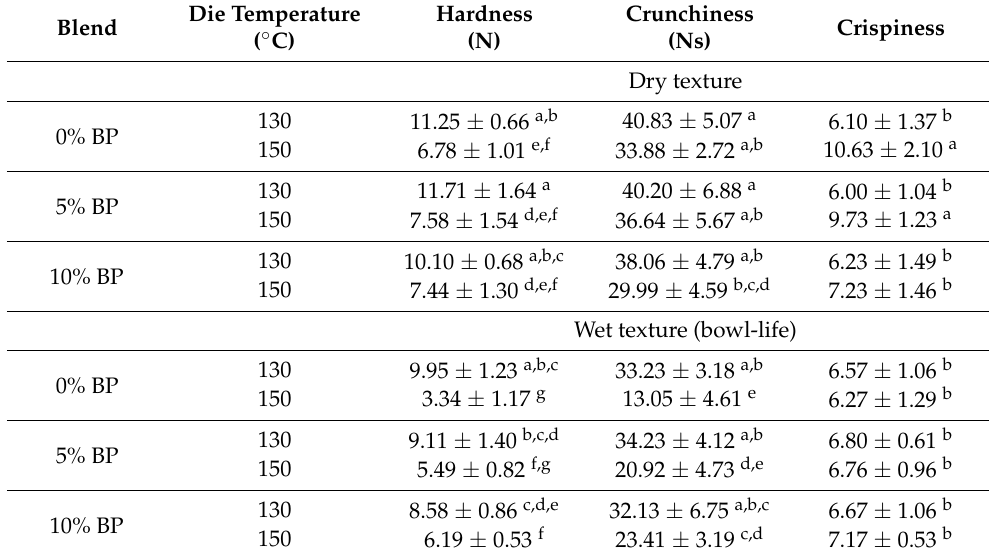
Table 2. Textural properties (mean ± standard deviation) of extrudates as a function of extrusion die temperature and butterfly pea flower (BP) concentration. Values in the same column followed with same letters are not significantly different ( n = 2 for extrusion runs and n = 3 for textural